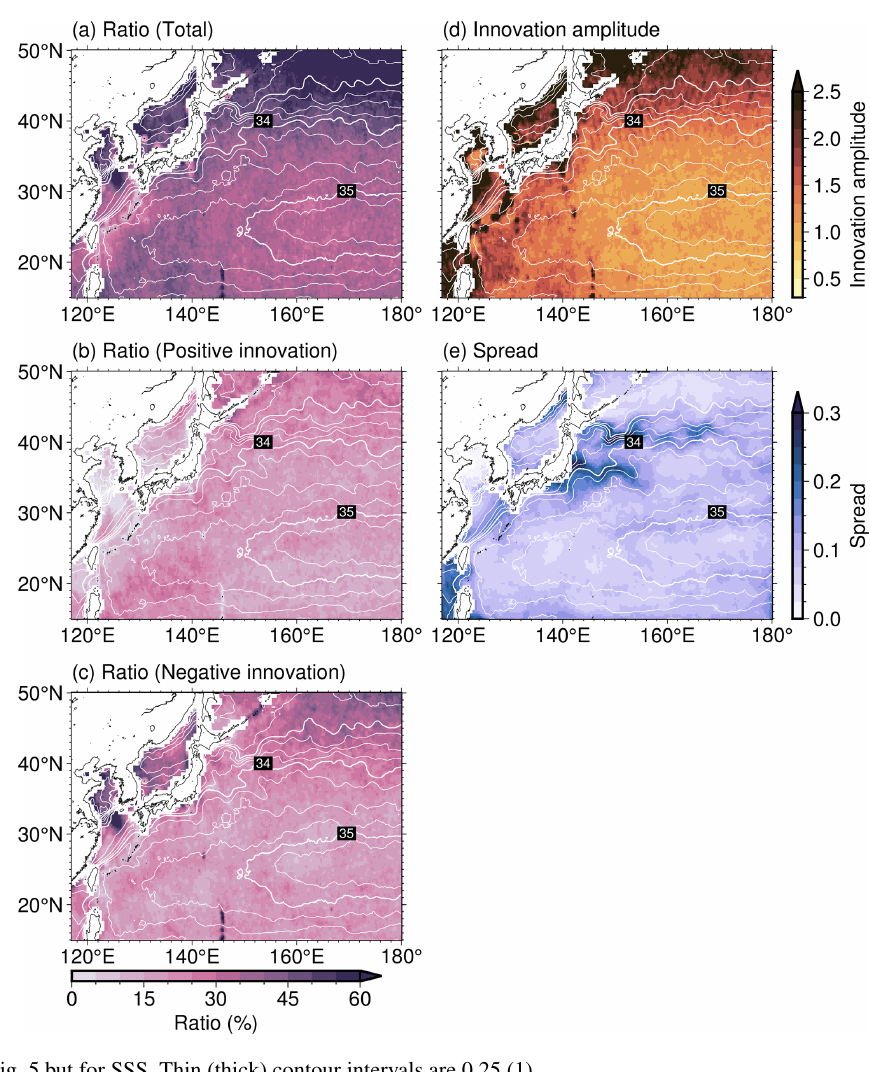
Figure 6. Same as Fig. 5 but for SSS. Thin (thick) contour intervals are 0.25 (1).